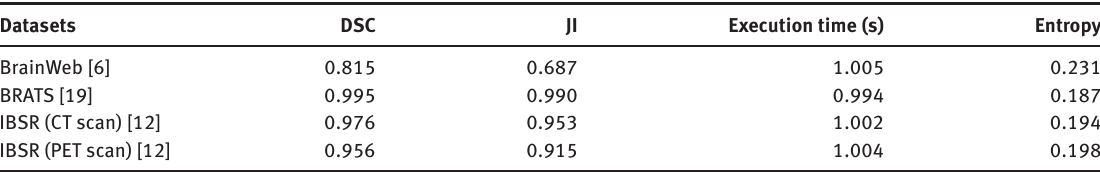
Table 4: Comparison of Ground Truth and Tumour Area Segmented by the Proposed Segmentation Method for the Brain Tumour